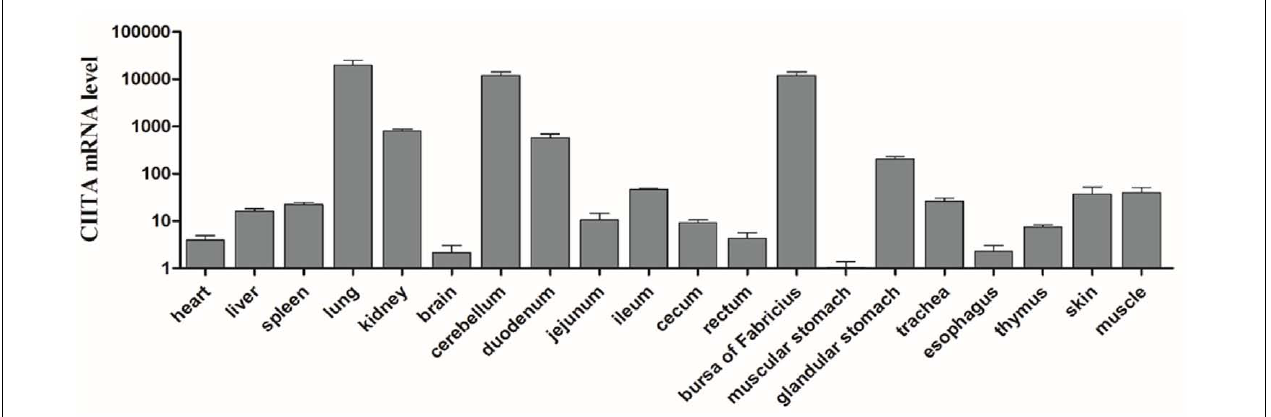
FIGURE 5 | Tissue distributions of CIITA in the healthy Cherry Valley duck. The relative mRNA levels were normalized to the expression of the β -actin gene from various tissues. The data were normalized to the muscular stomach, and error bars indicated the SD.